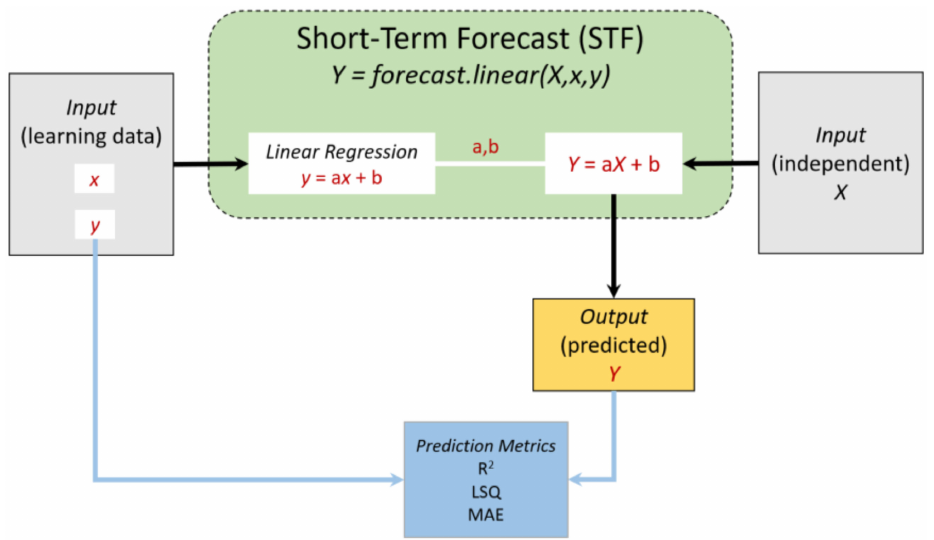
Figure 5. A scheme showing the short-term forecast (STF) model.